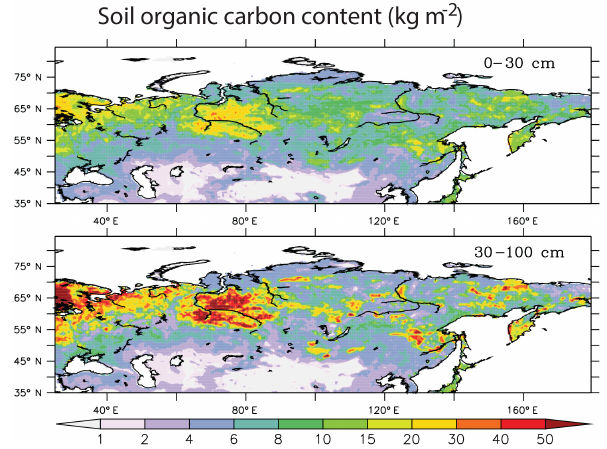
Figure 1. Spatial distribution of the observed soil organic carbon content over two soil horizon (0–30 and 30–70cm) at 0.5 ◦ by 0.5 ◦ resolution. Observations come from the Harmonized World Soil Database at 1km resolution of the Food and Agricultural Organi-